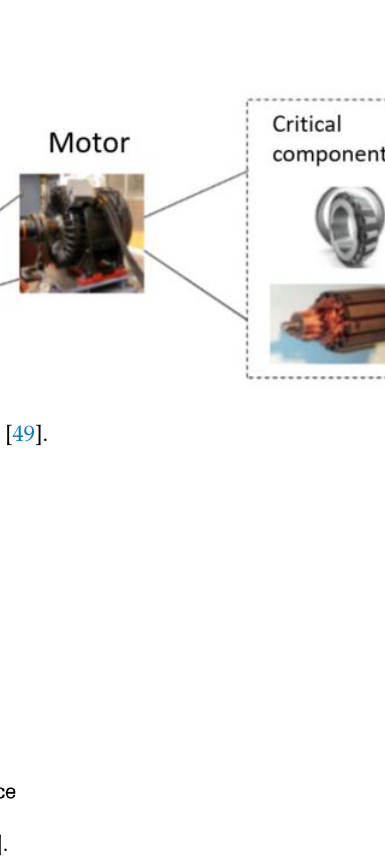
Figure 5. Mechanical rolling bearing system